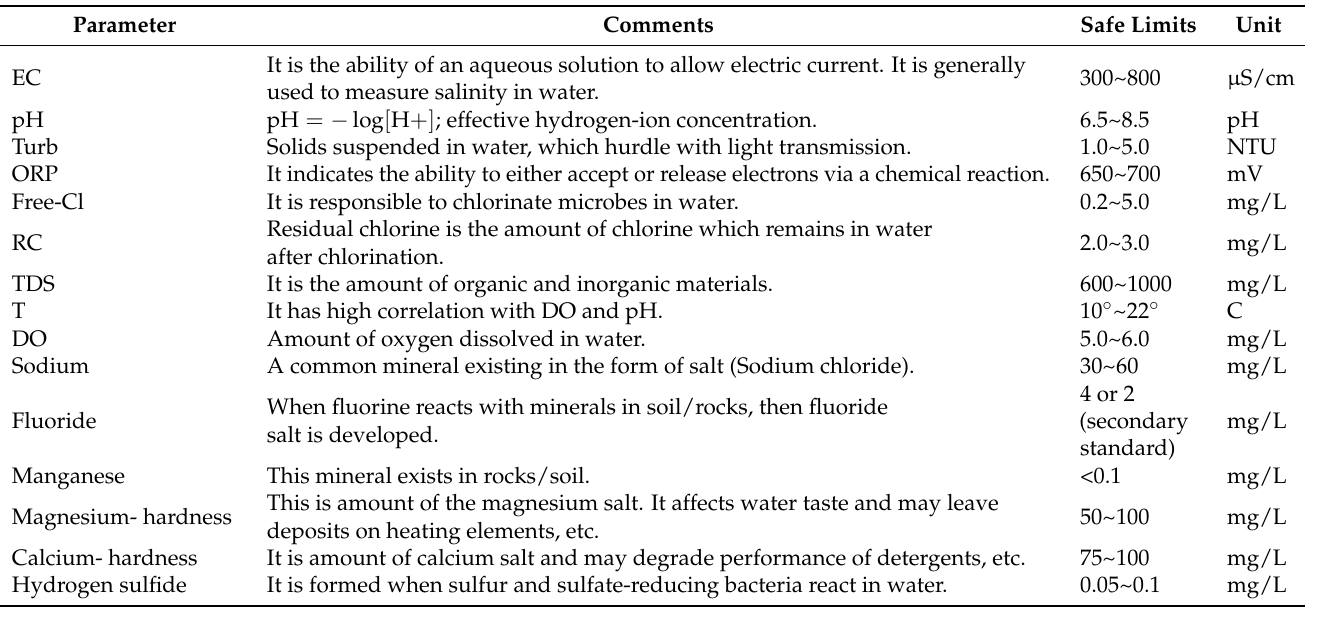
Table 3. WQM parameters safe limits for drinking water.